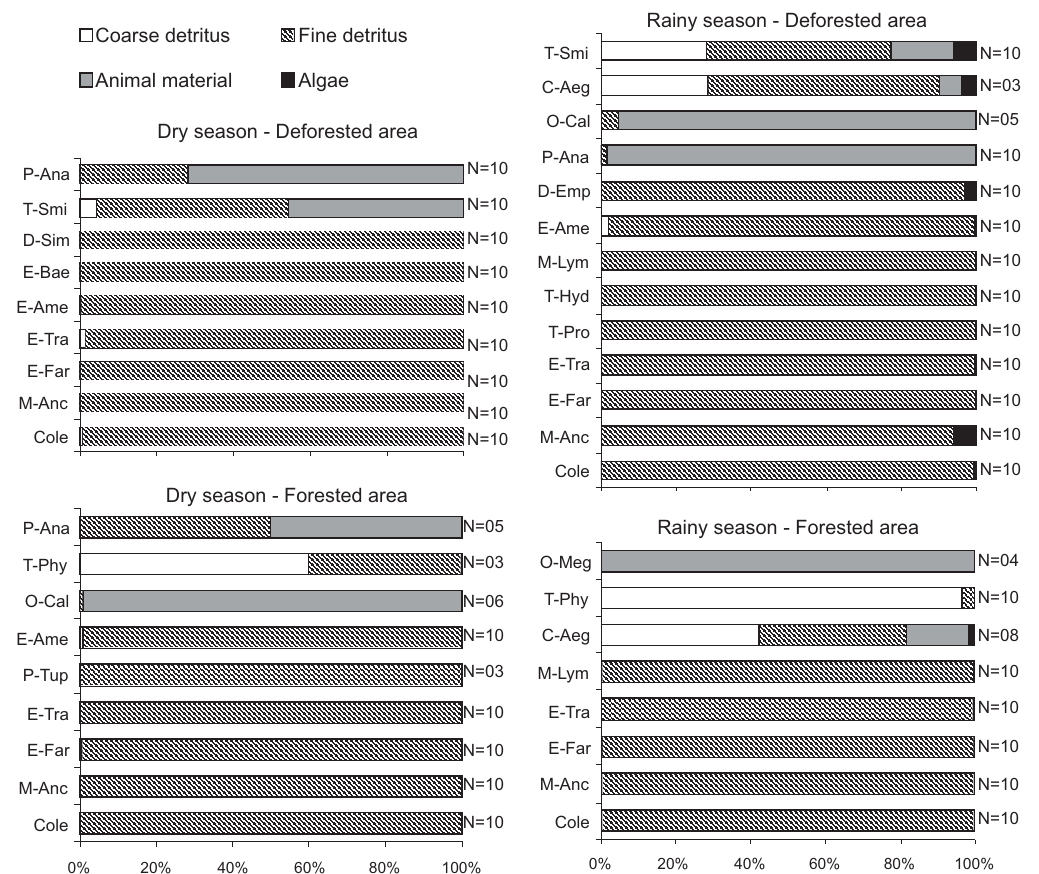
Figure 4. Diet composition (percentage of each food type in the gut contents) of the invertebrates sampled in leaf-bags incubated in the Ribeirão da Quinta stream, during the dry (July 2004) and rainy (December 2004) seasons and at two areas. (C-Aeg) Crustacea- Aegla castro , (Cole) Coleoptera- Heterelmis , (D-Emp) Diptera-Empididae, (D-Sim) Diptera-Simuliidae, (E-Ame) Ephemeroptera- Americabaetis , (E-Bae) Ephemeroptera- Baetodes , (E-Far) Ephemeroptera- Farrodes , (E-Tra) Ephemeroptera- Traverhyphes , (M-Anc) Mollusca-Ancylidae, (M-Lym) Mollusca-Lymnaeidae, (O-Cal) Odonata- Hetaerina , (O-Meg) Odonata- Heteragrion , (P-Ana) Plecoptera- Anacroneuria , (P-Tup) Plecoptera- Tupiperla , (T-Hyd) Trichoptera- Hydroptila , (T-Phy) Trichoptera- Phylloicus , (T-Pro) Trichoptera- Protoptila , (T-Smi)